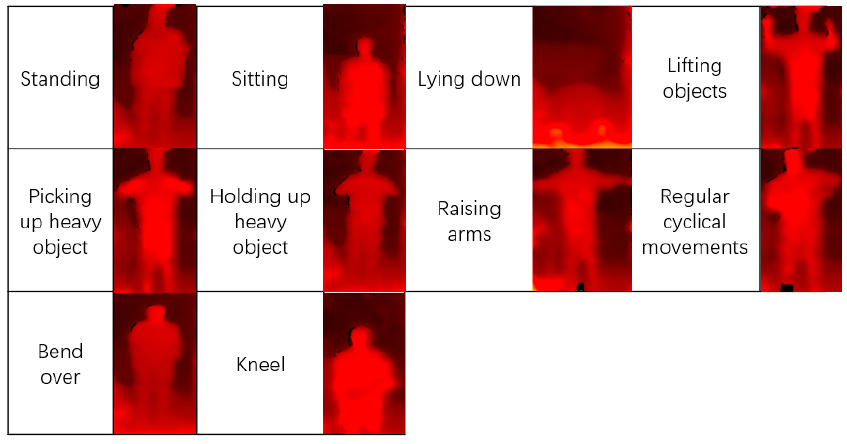
Figure 9. Example group of optimized depth motion capture for situation 1.